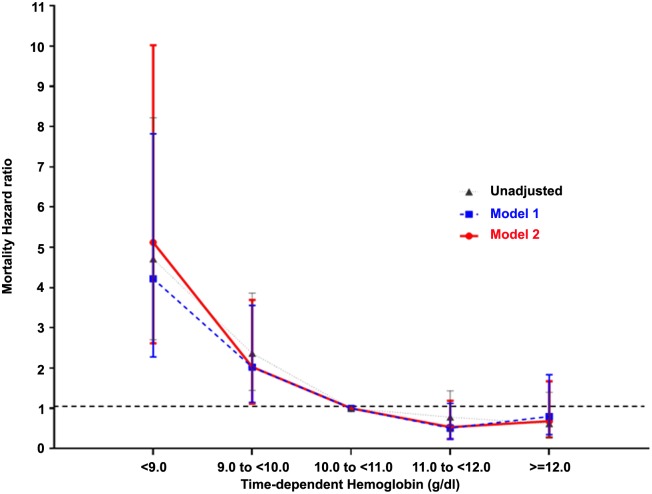
Hazard ratios of mortality based on time-dependent hemoglobin (Hb) levels in all the patients.Multivariate analysis sequentially adjusted models for covariates as follows. Model 1: age, sex, dialysis vintage, diabetes, cardiovascular disease, albumin, and high-sensitivity C-reactive protein; Model 2: Model 1 + erythropoiesis-stimulating agent (ESA) dose, ferritin, and transferrin saturation (TSAT). ESA dose was categorized as untreated (reference), 1 to <5000, 5000 to <10000, 10000 to <15000, and ≥15000 IU/week. Ferritin was categorized as <100, 100 to <500, and ≥500 ng/mL. TSAT was categorized as <20, 20 to <50, and ≥50%.